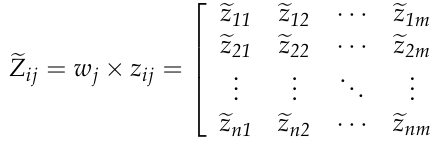
(cid:0) (cid:1) X ij 10 × 5